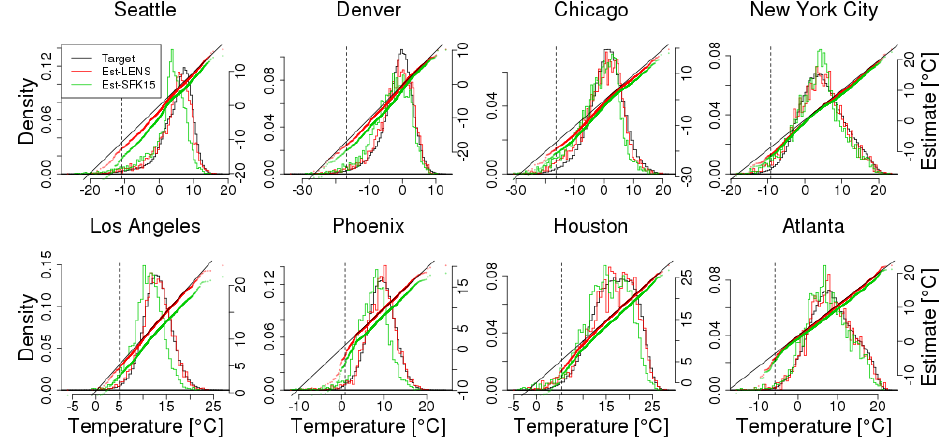
Figure 10. Similar to Fig. 9; comparisons between actual and projected LENS data for winter (DJF) using a model fit from the LENS data (in red) and using a model fit from the SFK15 ensemble (in green). Unlike Fig. 9, the projected data are obtained from one single simulation of the time period 1979–2016 projected 80 years into the future, 2059–2096. The actual target data draw from all 40 simulations (shown in black). The dashed vertical line represents the . 01 quantile of the initial distribution.